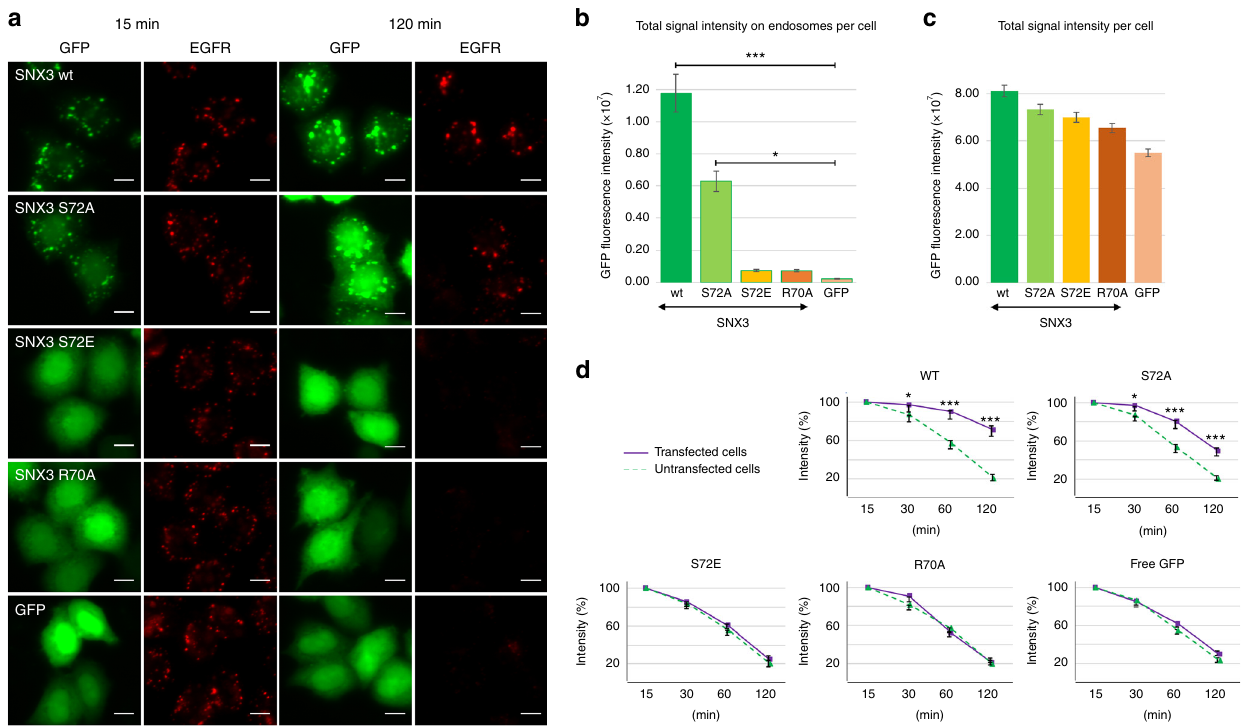
Fig. 6 Intracellular localization of Snx3 mutants, and their effects on EGF receptor degradation. a Cells were transiently transfected with cDNAs coding for the indicated GFP-SNX3 fusion proteins. 18 h after transfection cells were starved for 4 h, challenged with EGF for 15 or 120 min, fi xed and stained with anti- EGF recetptor antibodies. The cells were then analyzed by automated microscopy. Bar: 10 µ m. b , c In a , the total GFP fl uoresence intensity of endosomes containing the EGF receptor after 15 min was quanti fi ed per cell ( b ) and is compared to the total intensity of the GFP fl uorescence signal per cell ( c ). d The experiments was as in a for the indicated time periods. The total EGF receptor per cell was quanti fi ed in transfected cells (solid line) and in neighboring untransfected cells (dashed line) from the same well of the 96-well plates. The integrated intensity is expressed as a percentage of the values observed at 15 min. b – d Aproximately 1000 cells were analysed per condition in n = 3 independent experiments. Error bars indicate SEM. Statistical signi fi cance is calculated using one-way ANOVA analysis with Bonferonni ’ s post-test. Levels of signi fi cance are indicated as follows: * p < 0.05; *** p <